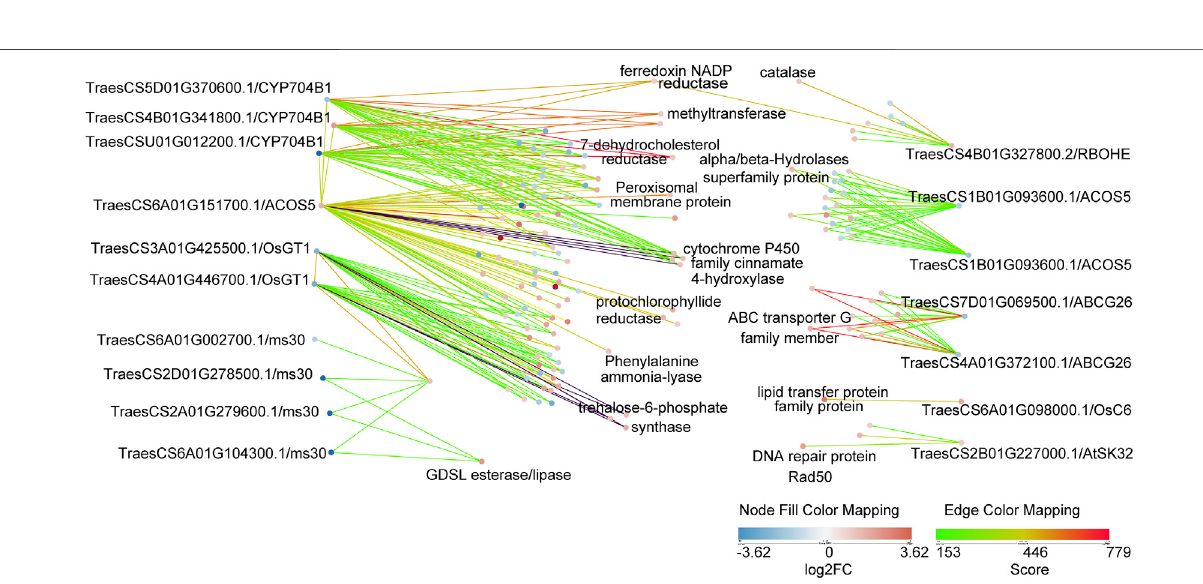
Frontiers in Genetics |